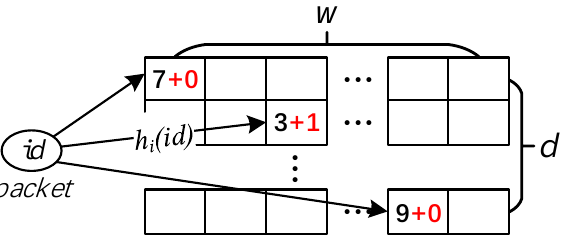
Figure 2. Example of a conservative update (CU)